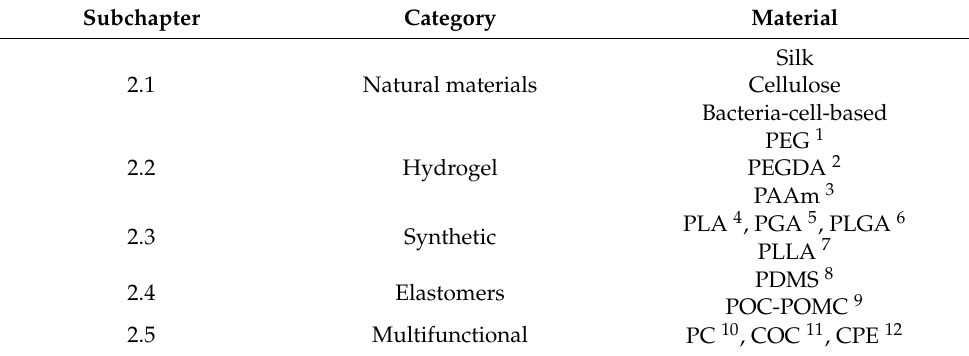
Table 1. Classification of biocompatible polymer optical